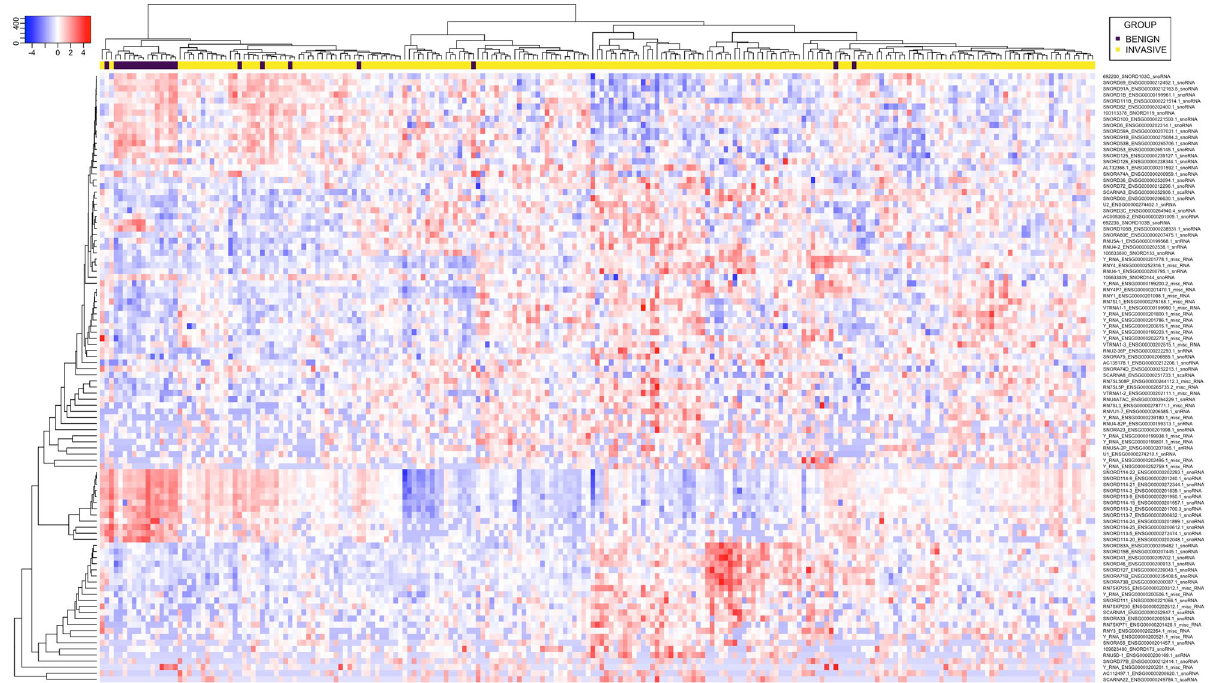
Figure 1. Ninety-six sncRNAs were found to significantly ( Padj < 0.01) distinguish invasive local BC from benign breast tissue. The hierarchical clustering of 186 invasive local BC and 22 benign breast tissue samples (columns) and differentially expressed sncRNAs (rows) using Pearson metrics. Log2 fold change is marked by the color scale (from blue to